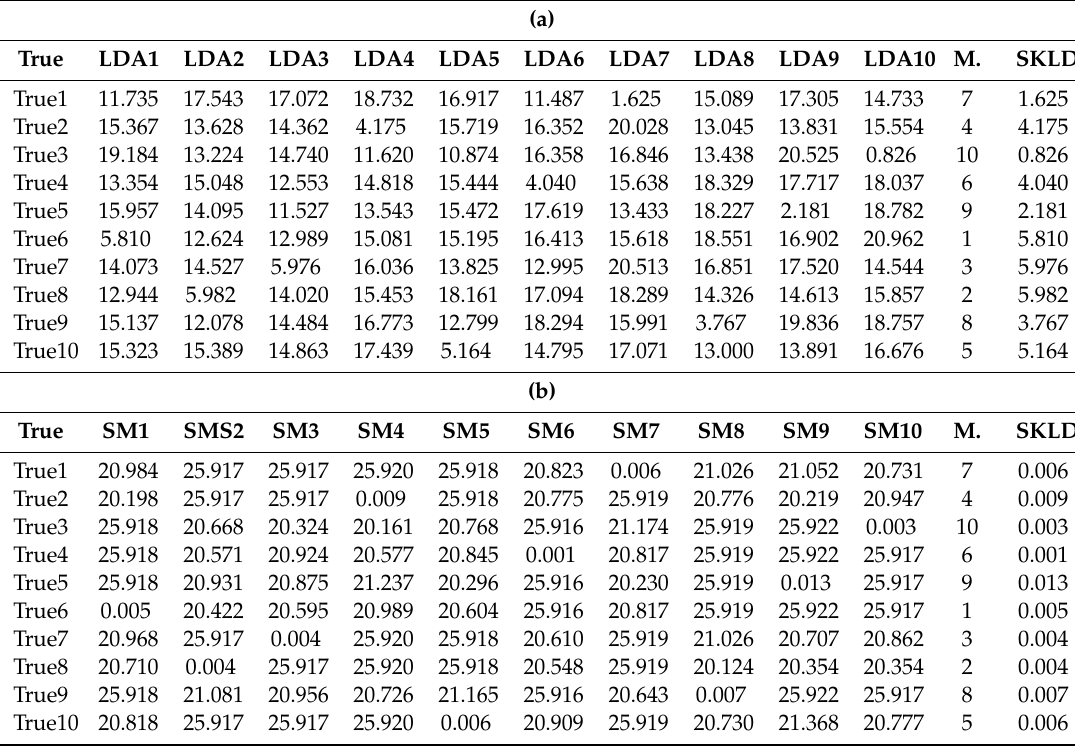
Table 4. KL distances from: ( a ) sampling (S) to LDA topics; ( b ) sampling to ERT (SM)